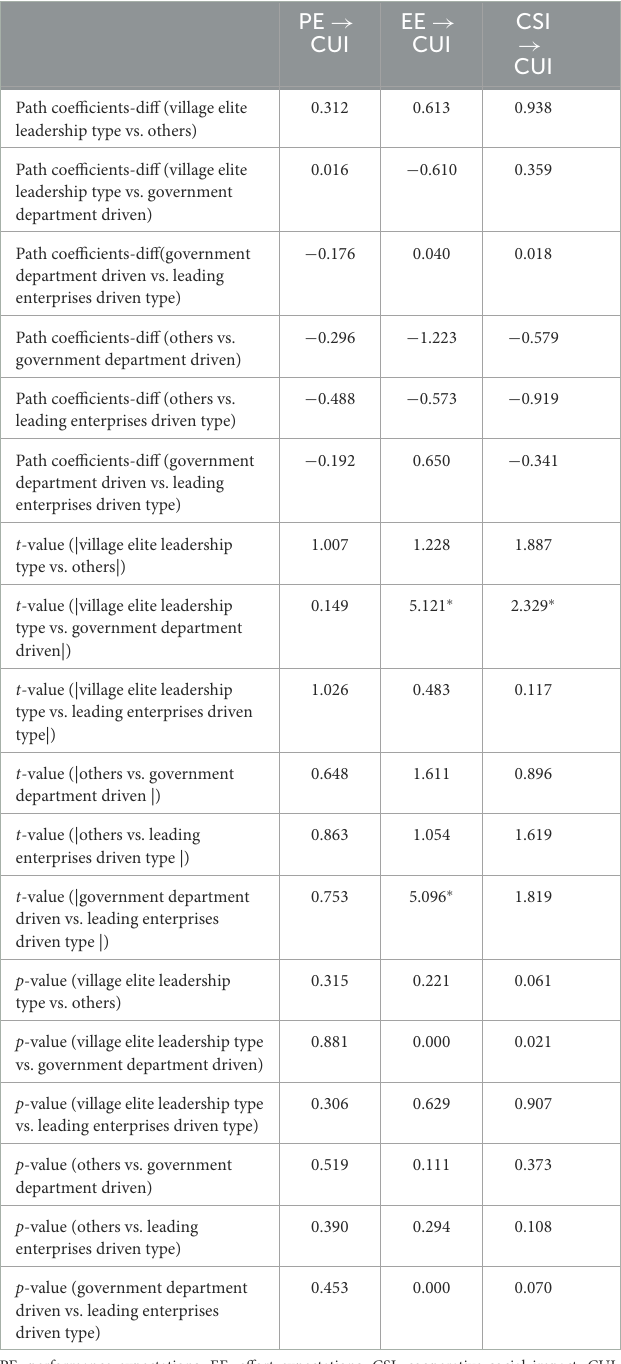
PE → EE → CSI → CUI CUI CUI